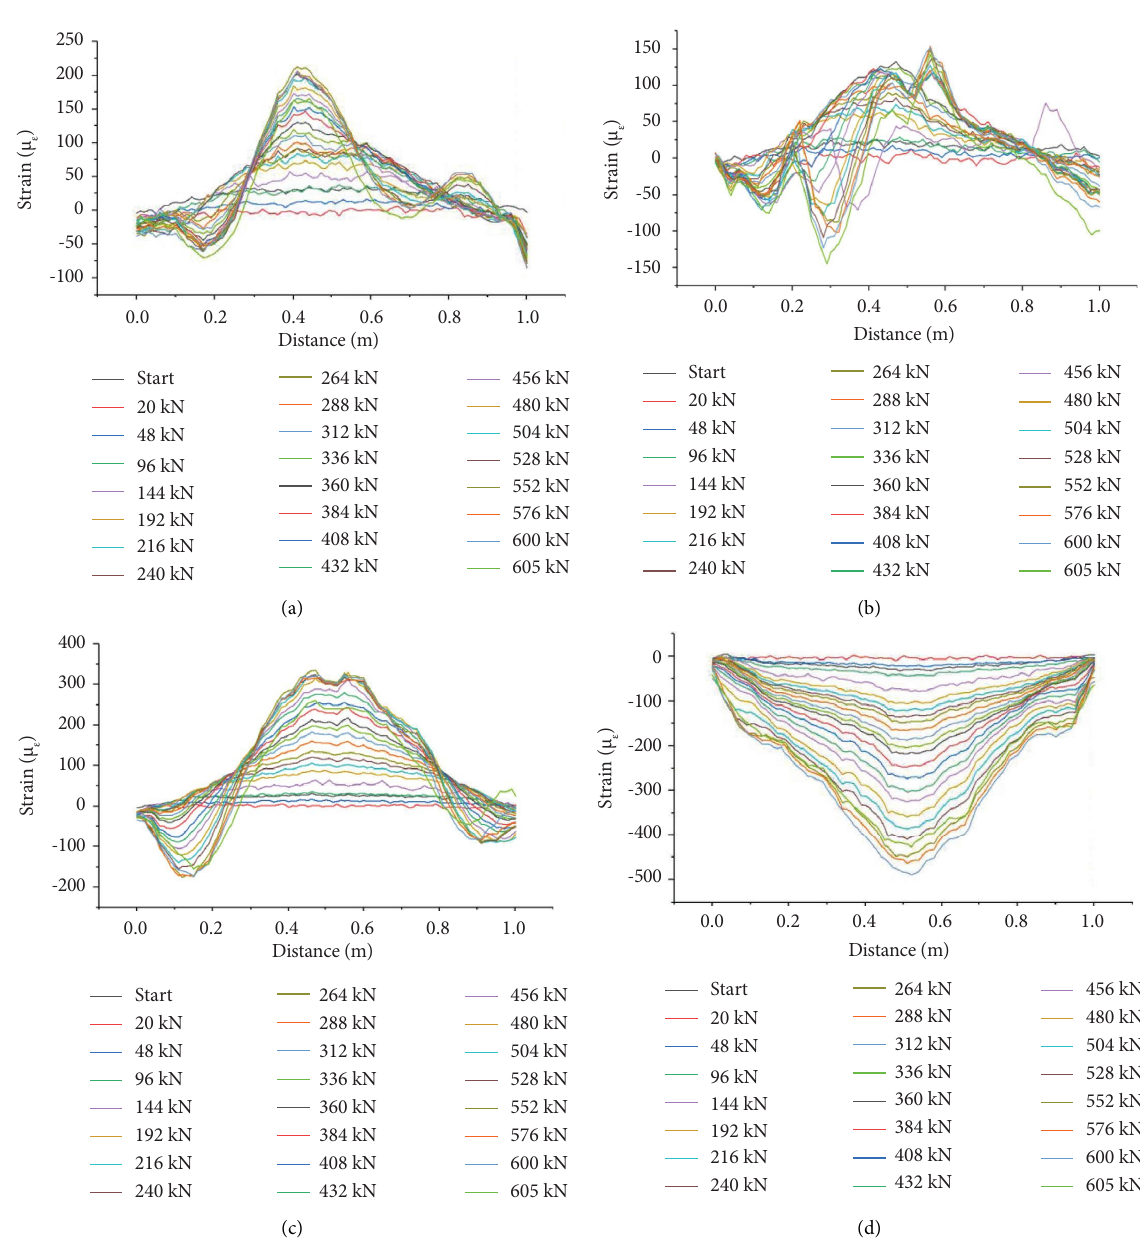
Figure 10: Strain diagram of carbon fber optical cable on the top, back, and front of 5-1 (a) Top. (b) Back. (c) Upper of front. (d) Lower of